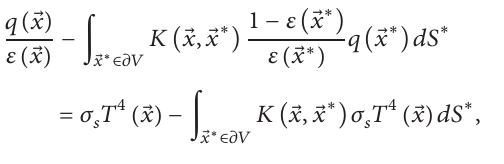
Figure 1: Configuration inside the furnace (1: melt; 2: crystal; 3-4: crucibles; 5-6: pedestals; 7–11: heat shields; 12–15: heaters).